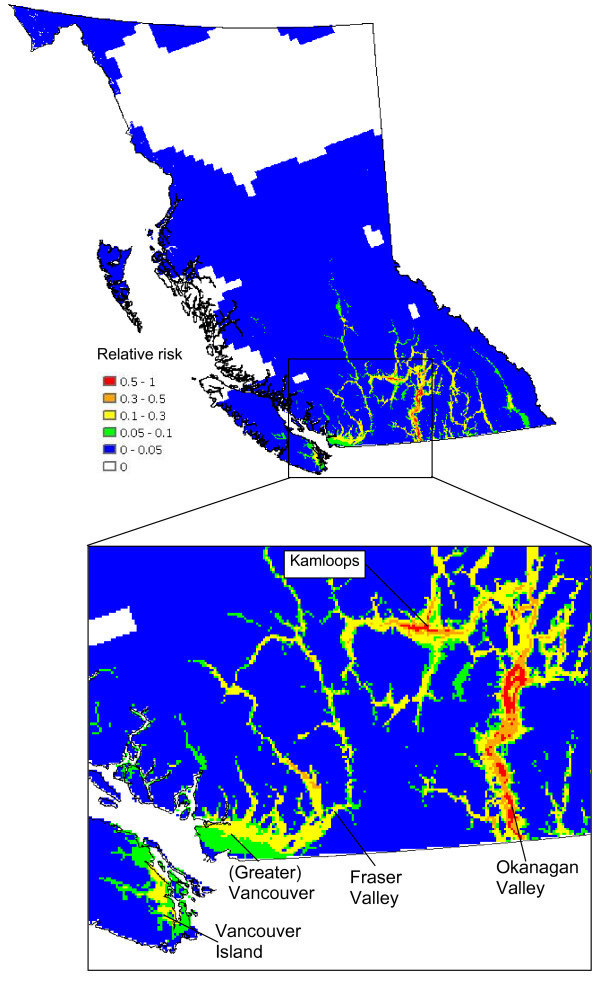
Total risk of forming a mosquito-bird cycle. All of BC (upper) and a more detailed look at the high risk areas (lower) (Normalized product of Figures 6 and 7 divided by the maximum value)